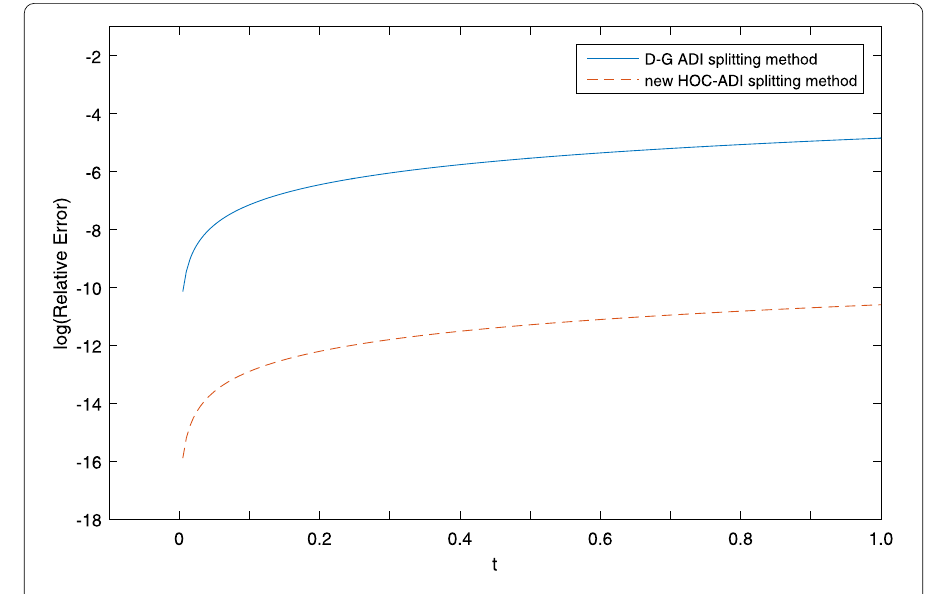
Figure 5 Comparison of relative error using D-G ADI splitting scheme and new HOC-ADI splitting scheme for Example 2